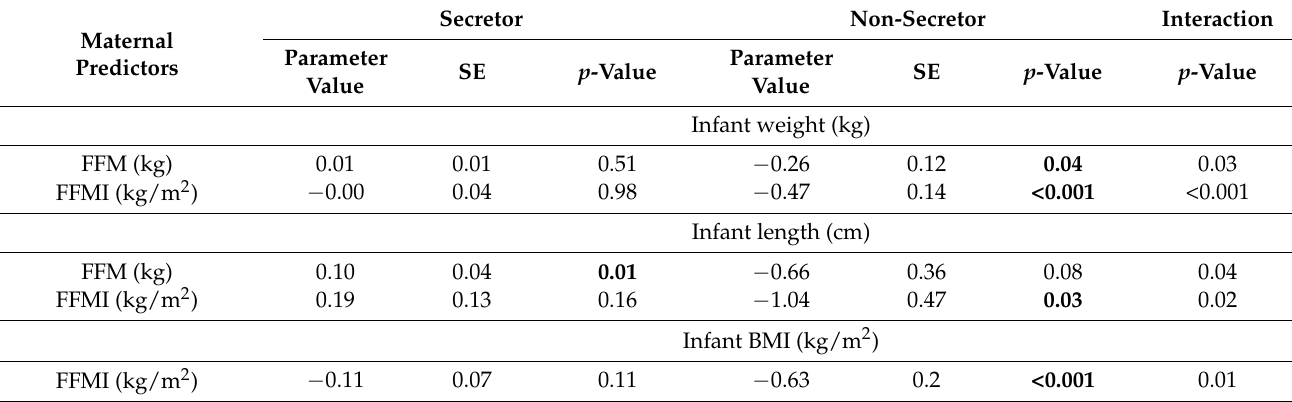
Table 3. Associations between maternal and infant body composition at three months